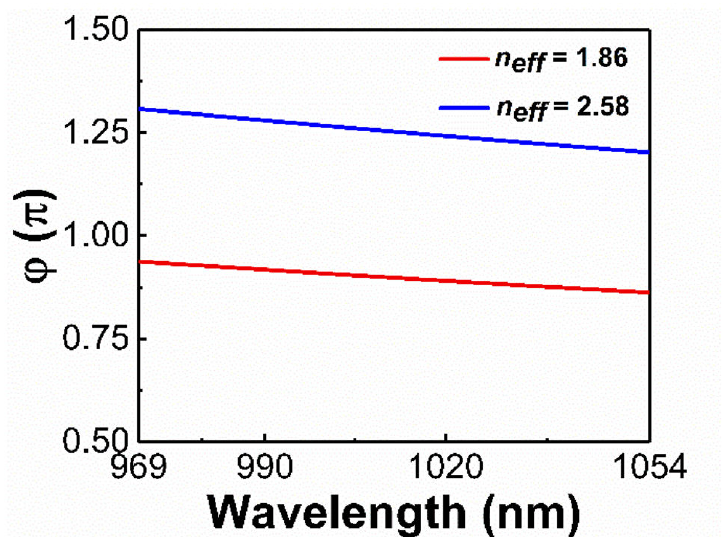
Figure A2. Within the wavelength range of 969 nm to 1054 nm, the calculated propagation phase is shown for the effective refractive index of 1.86 and 2.58,